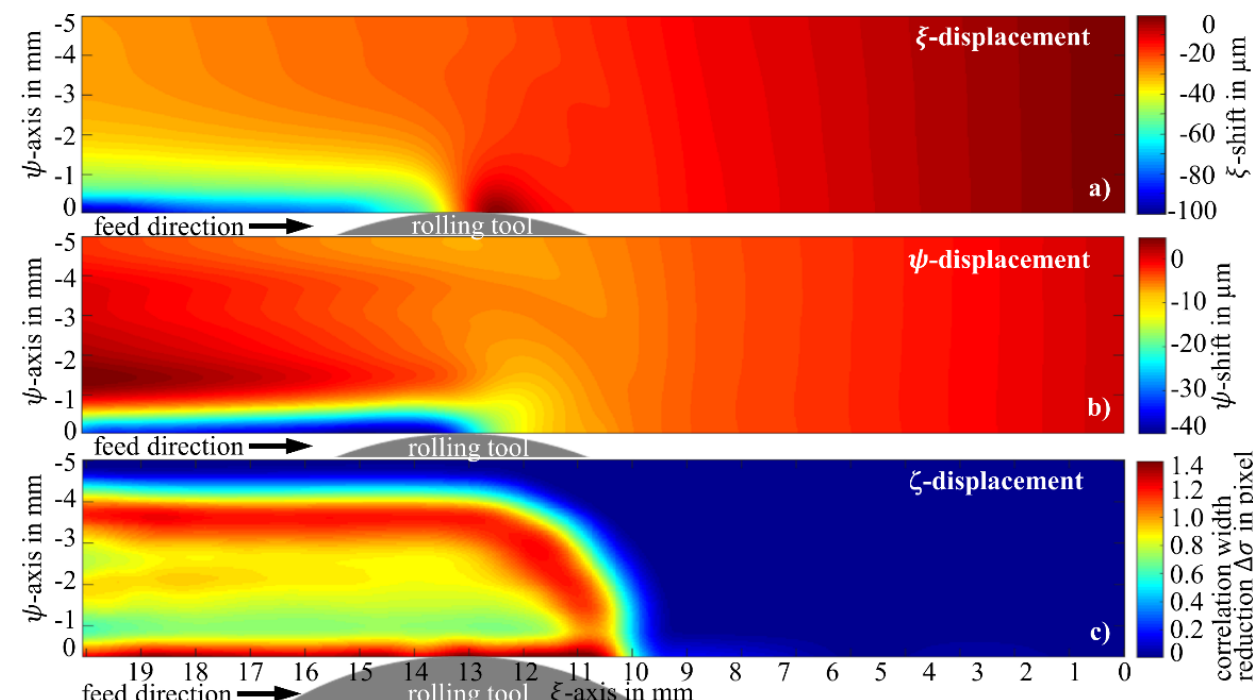
Figure 7. In-process measurement in the deep rolling process: The occurring shifts in ξ -direction ( a ) and Ψ -direction ( b ) as well as the reduction of the calculated width of the correlation function resulting from the out-of-plane shift as a value for the ζ -shift ( c ) are shown.